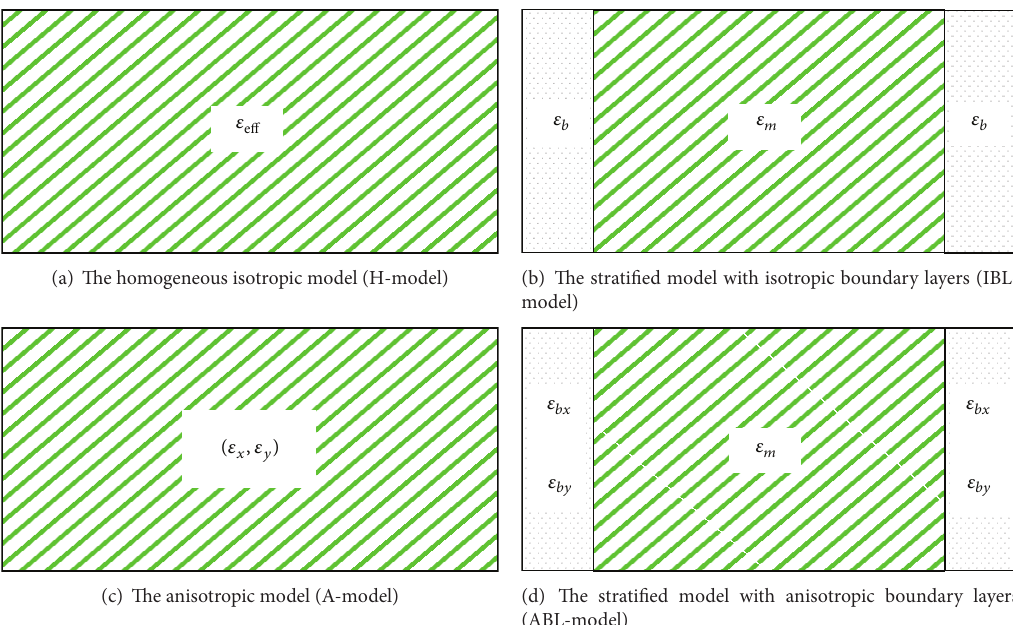
Figure 2: Four different models applied to characterize the dielectric slab in Figure 1. In (a), 𝜀 is the relative effective permittivity of the eff homogeneous model; 𝜀 𝑏 and 𝜀 𝑚 in (b) are the permittivities of the outermost boundary and inner layers; 𝜀 𝑥 and 𝜀 𝑦 in (c) denote the 𝑥 - and 𝜀 𝑥 - and 𝑦 -components of the permittivities of the outermost boundary layers, 𝑦 -components of the permittivity; 𝜀 𝑏𝑥 and 𝑏𝑦 in (d) are the while 𝜀 𝑚 is the inner layer